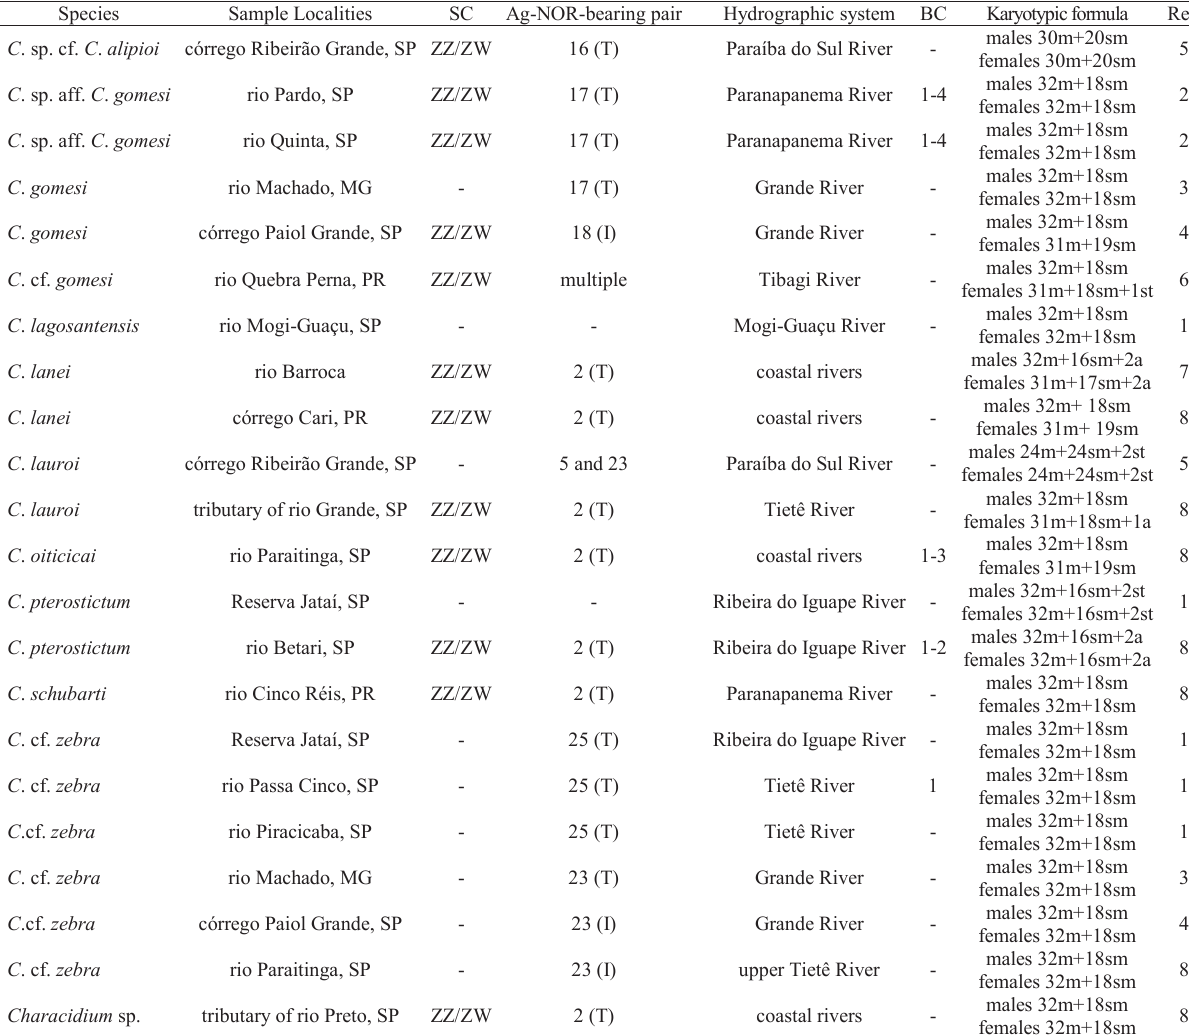
Table 2. Cytogenetic data available for the genus Characidium (2n=50 chromosomes). Ref. = 1. Miyazawa & Galetti Jr. (1994); 2. Maistro et al . (1998); 3. Silva & Maistro (2006); 4. Centofante et al . (2001); 5. Centofante et al . (2003); 6. Vicari et al . (2008); 7. Noleto et al . (2009); 8. Present study. SC = Sex Chromosomes System; NOR Position on Chromosomes T = terminal. I = interstitial; BC = Number of B Chromosomes; SP = São Paulo State; MG = Minas Gerais State; PR = Paraná State. Species Sample Localities SC Ag-NOR-bearing pair Hydrographic system BC Karyotypic formula